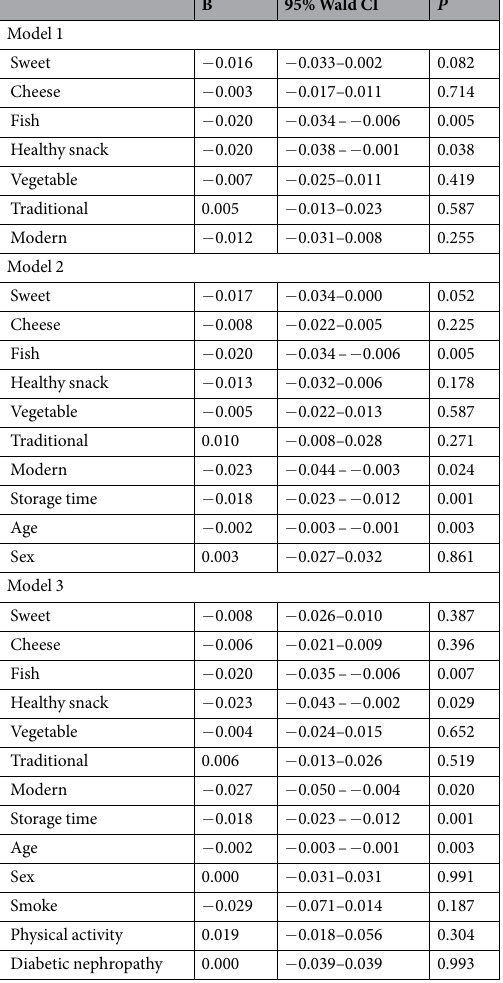
Table 3. Associations between factor analysis-derived dietary patterns and serum LPS activity in 668 individuals. Generalized linear model. Factors are formed from the food frequency questionnaire data.